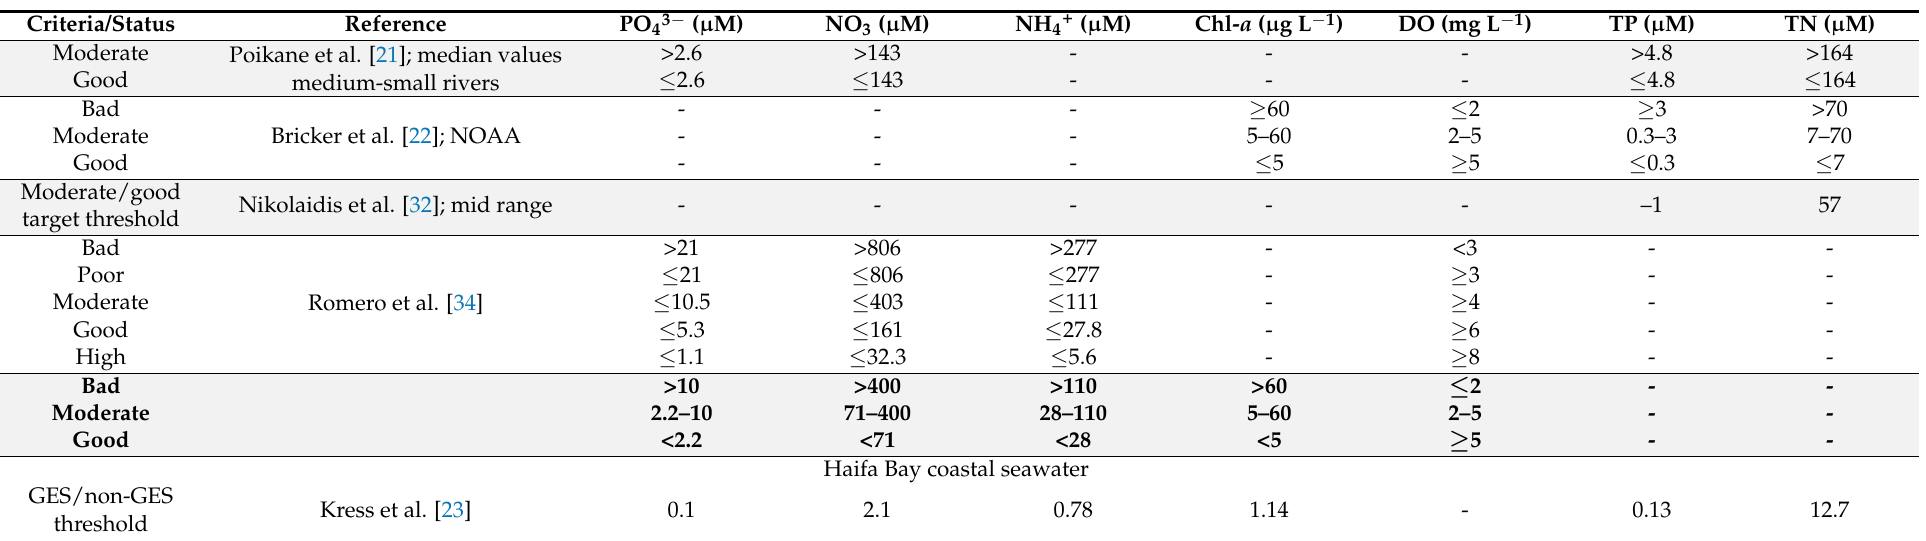
Table 2. Summary of nutrient, chl- a and DO thresholds for river and estuarine